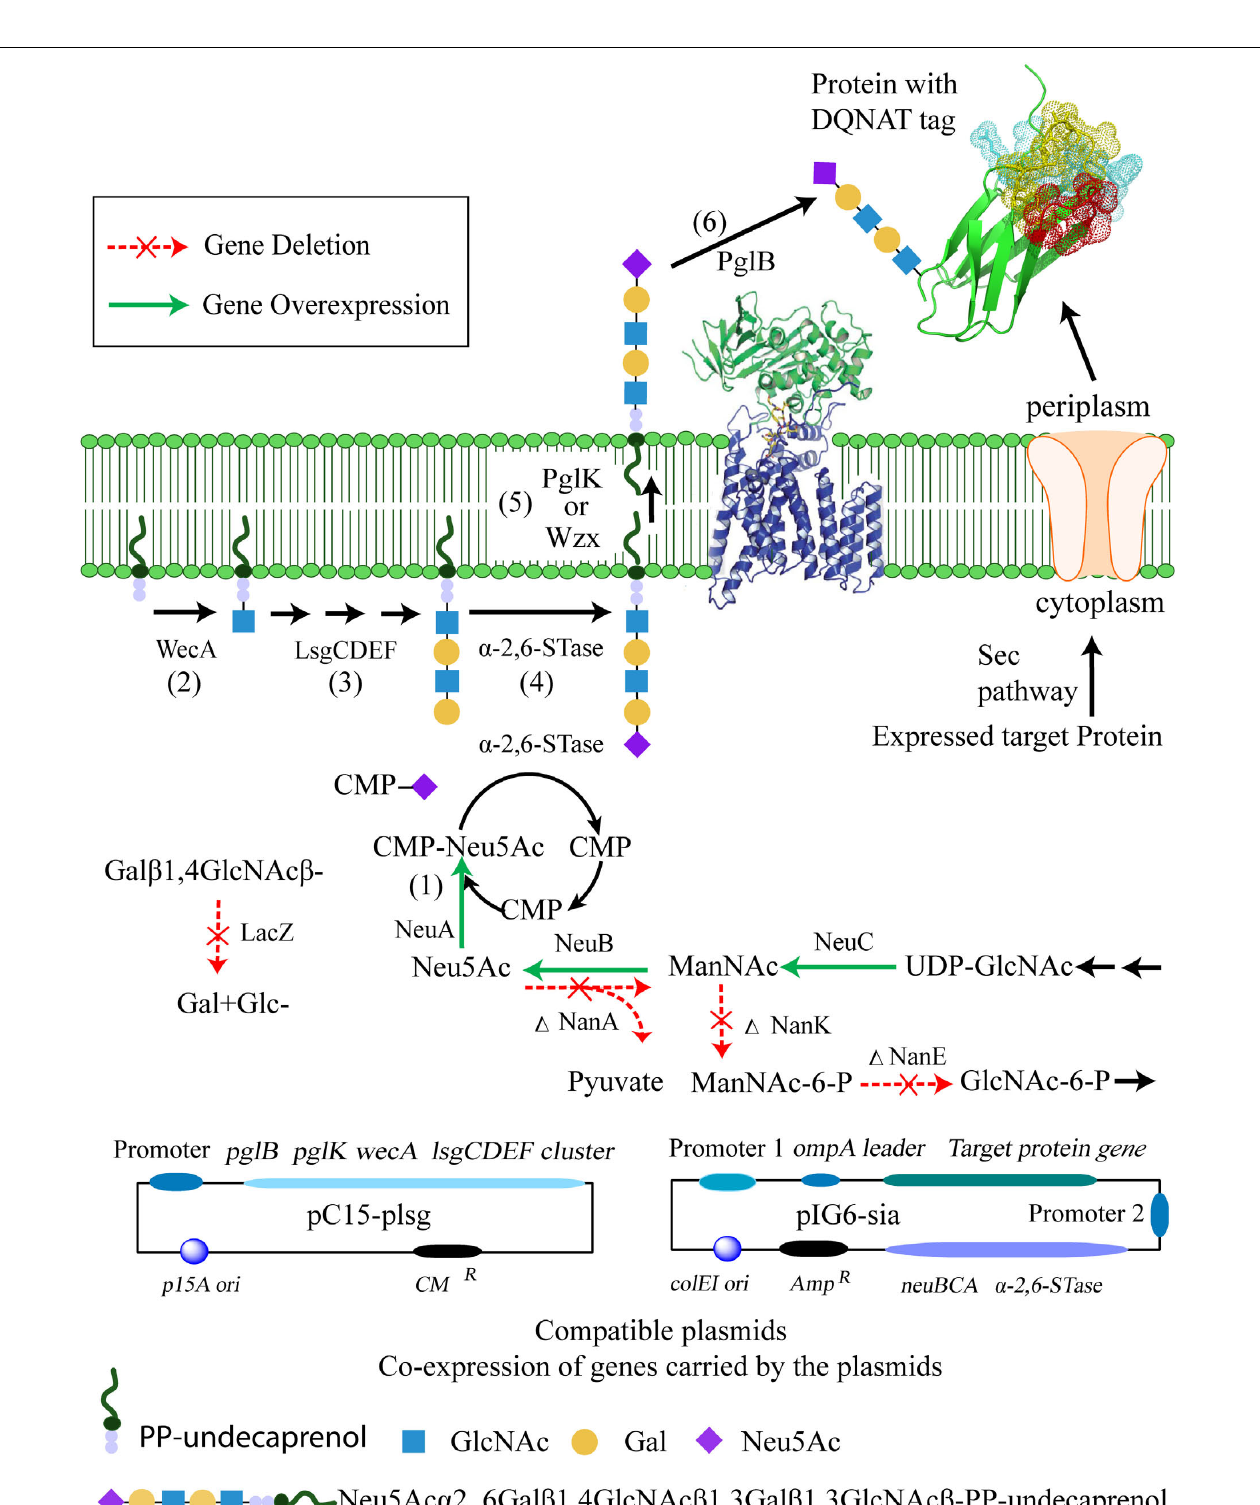
FIGURE 1 | The proposed biosynthetic pathway for the production of terminally sialylated proteins in the periplasm of E. coli , and associated plasmid constructs. Synthesis of CMP-Neu5Ac is achieved by the sub-pathway constructed with overexpressed neuBCA genes from C. jejuni (1). Synthesis of the pentasaccharide LLOs Gal- β -1,4-GlcNAc- β -1,3-Gal- β -1,3-GlcNAc- β -pp-undecaprenol and Neu5Ac- α -2,6-Gal- β -1,4-GlcNAc- β -1,3-Gal- β -1,3-GlcNAc- is achieved by the sub-pathway constructed with GlcNAc-1-phosphate glycosyltransferase (WecA) enzyme (2), glycosyltransferases (LsgCDEF) (3), and the α -2,6-STase ( pl-ST6 ) enzyme (4). The sialylated glycan is flipped by PglK (or Wzx) flipases from the cytoplasmic to the periplasmic side of the membrane (5). The final modification of the target protein with the synthesized glycan is achieved by PglB (6).